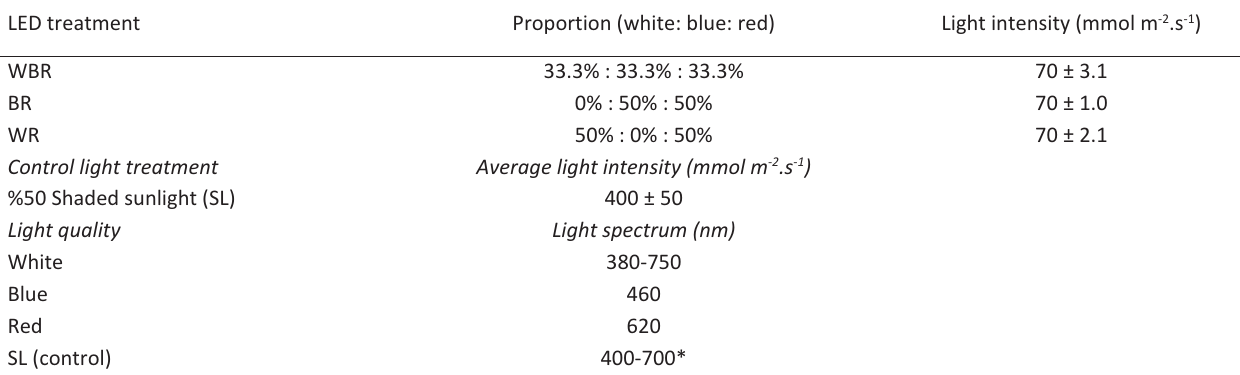
*: For comparing sunlight quality with LEDs, sunlight has purple/blue : green/yellow : orange/red (400­492 : 493­597 : 598­700 nm) with the relationship of 23 : 28 : 39 according to Aphalo et al .